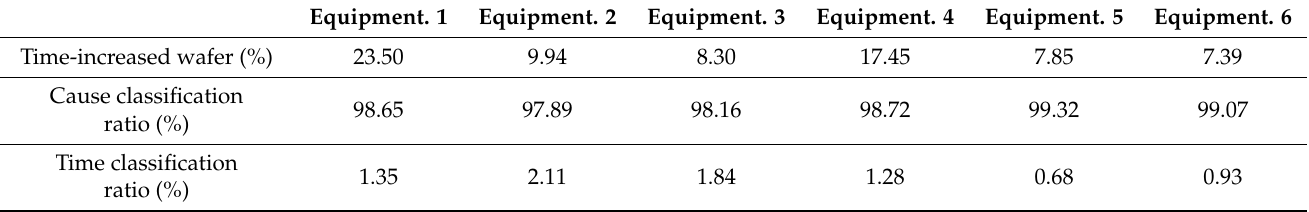
Table 3. Ratio of time-increased wafers in total wafers and ratio of cause and time classification. Equipment. 1